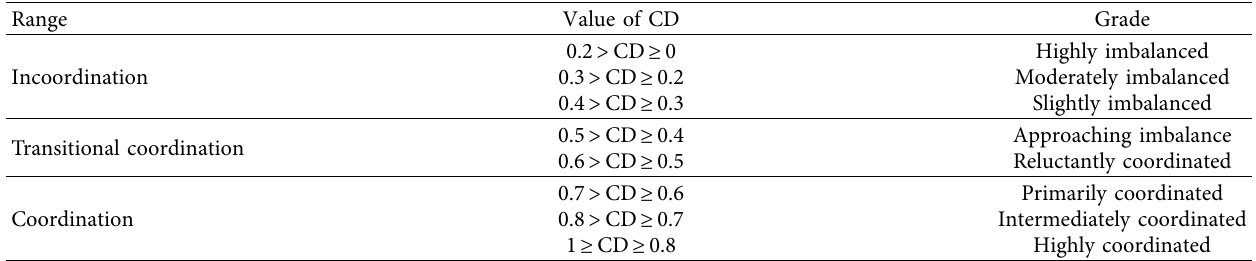
Table 2: Grade of CD.